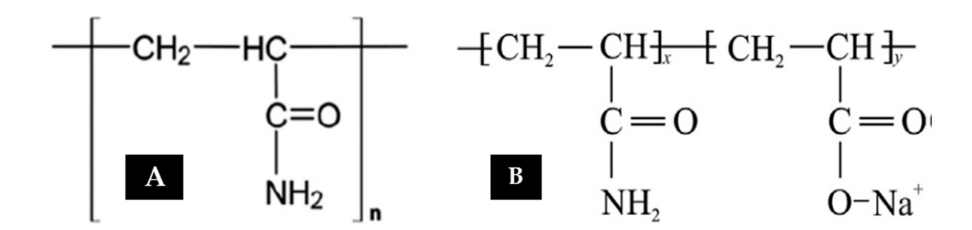
Figure 2. Chemical structure of ( A ) polyacrylamide (PAM) and ( B ) hydrolyzed polyacrylamide (HPAM). Reprinted and modified from [16]. Copyright @Elsevier